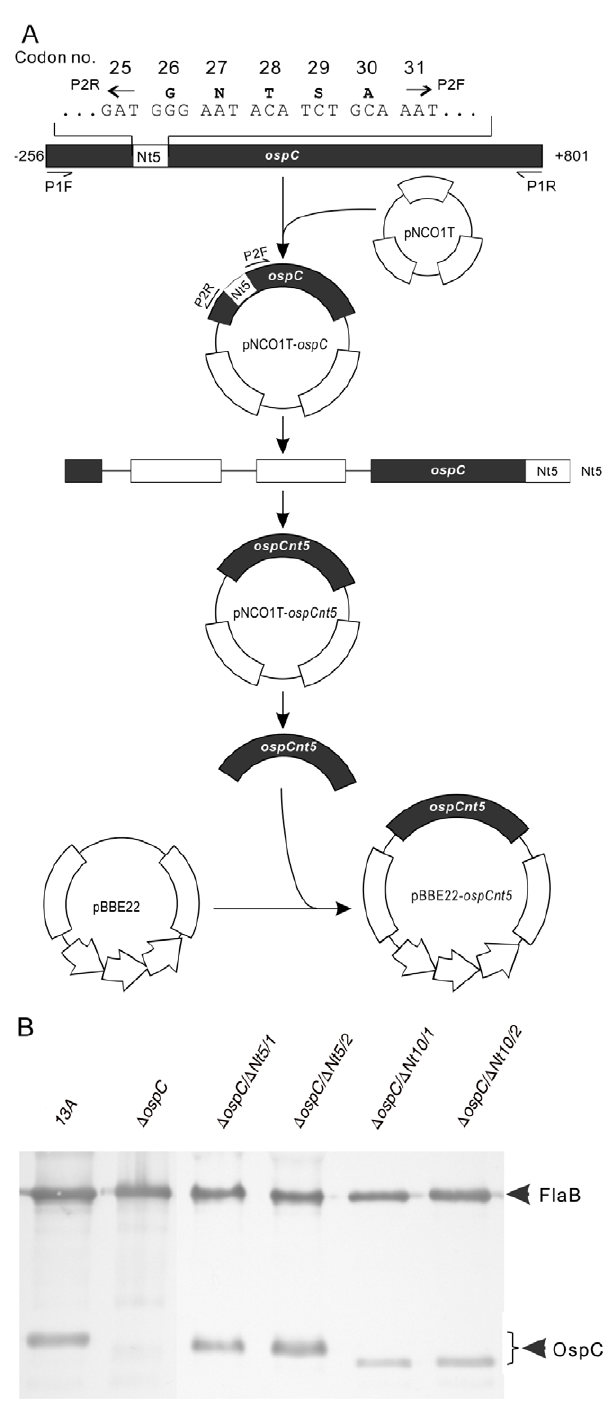
Figure 1. Generation of B.burgdorferi producing OspC with N- terminal 5-AA or 10-AA deletion. A) Construction of pBBE22- ospCnt5 and pBBE22- ospCnt10 . The five codons coding for the five amino acid residues (residues 26–30) and their adjacent codons are presented. The lipidation site, residue No. 19, is not shown. The amplification starting sites and directions of four primers, P1F, P1R, P2F and P2R, used for plasmid construction are also marked. The long bar represents the 1057-bp fragment, covering the entire ospC -coding region and down- (extending to + 801 from the transcriptional start site) and up-stream sequences (extending to -256). The same strategy was used to construct pBBE22- ospCnt10 . The detailed procedure was described in Materials and Methods. B) Restoration of OspC